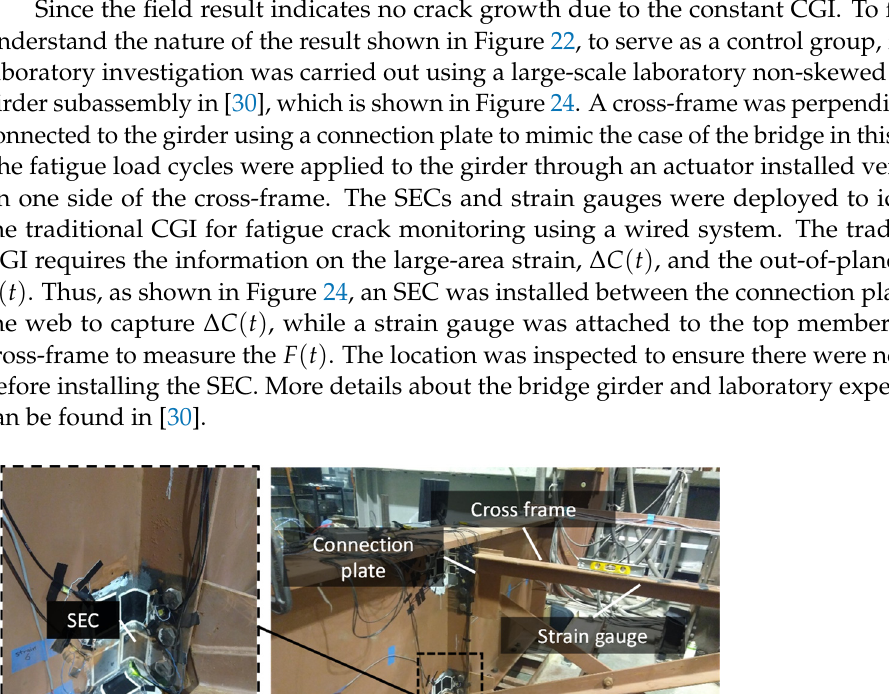
Figure 23. Number of peaks for computing the CGI.